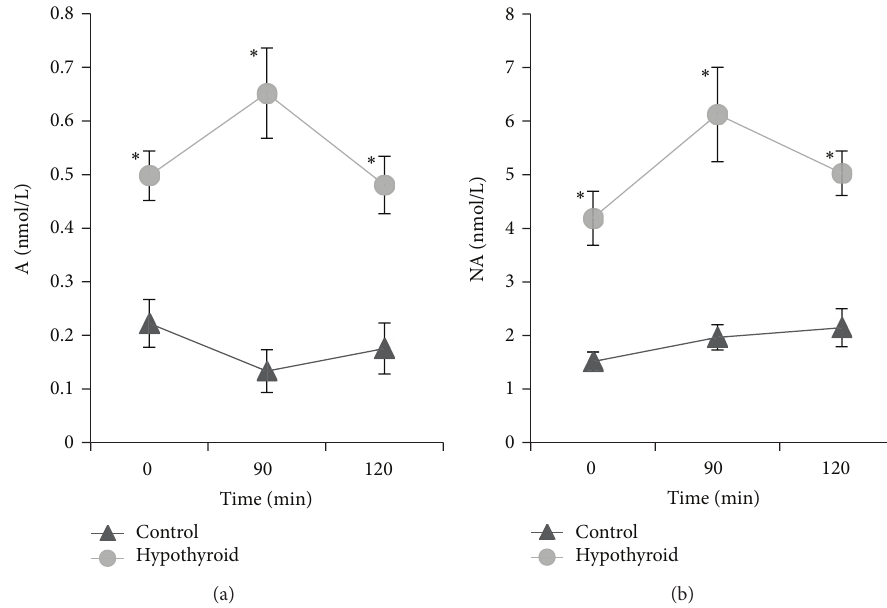
Figure 3: Mean values ± SE of fasting blood adrenaline and noradrenaline and their postglucose levels in the group of hypothyroid (hypothyroid) and healthy women (control). Asterisks denote differences between these groups; ∗ 𝑃 < 0.0002